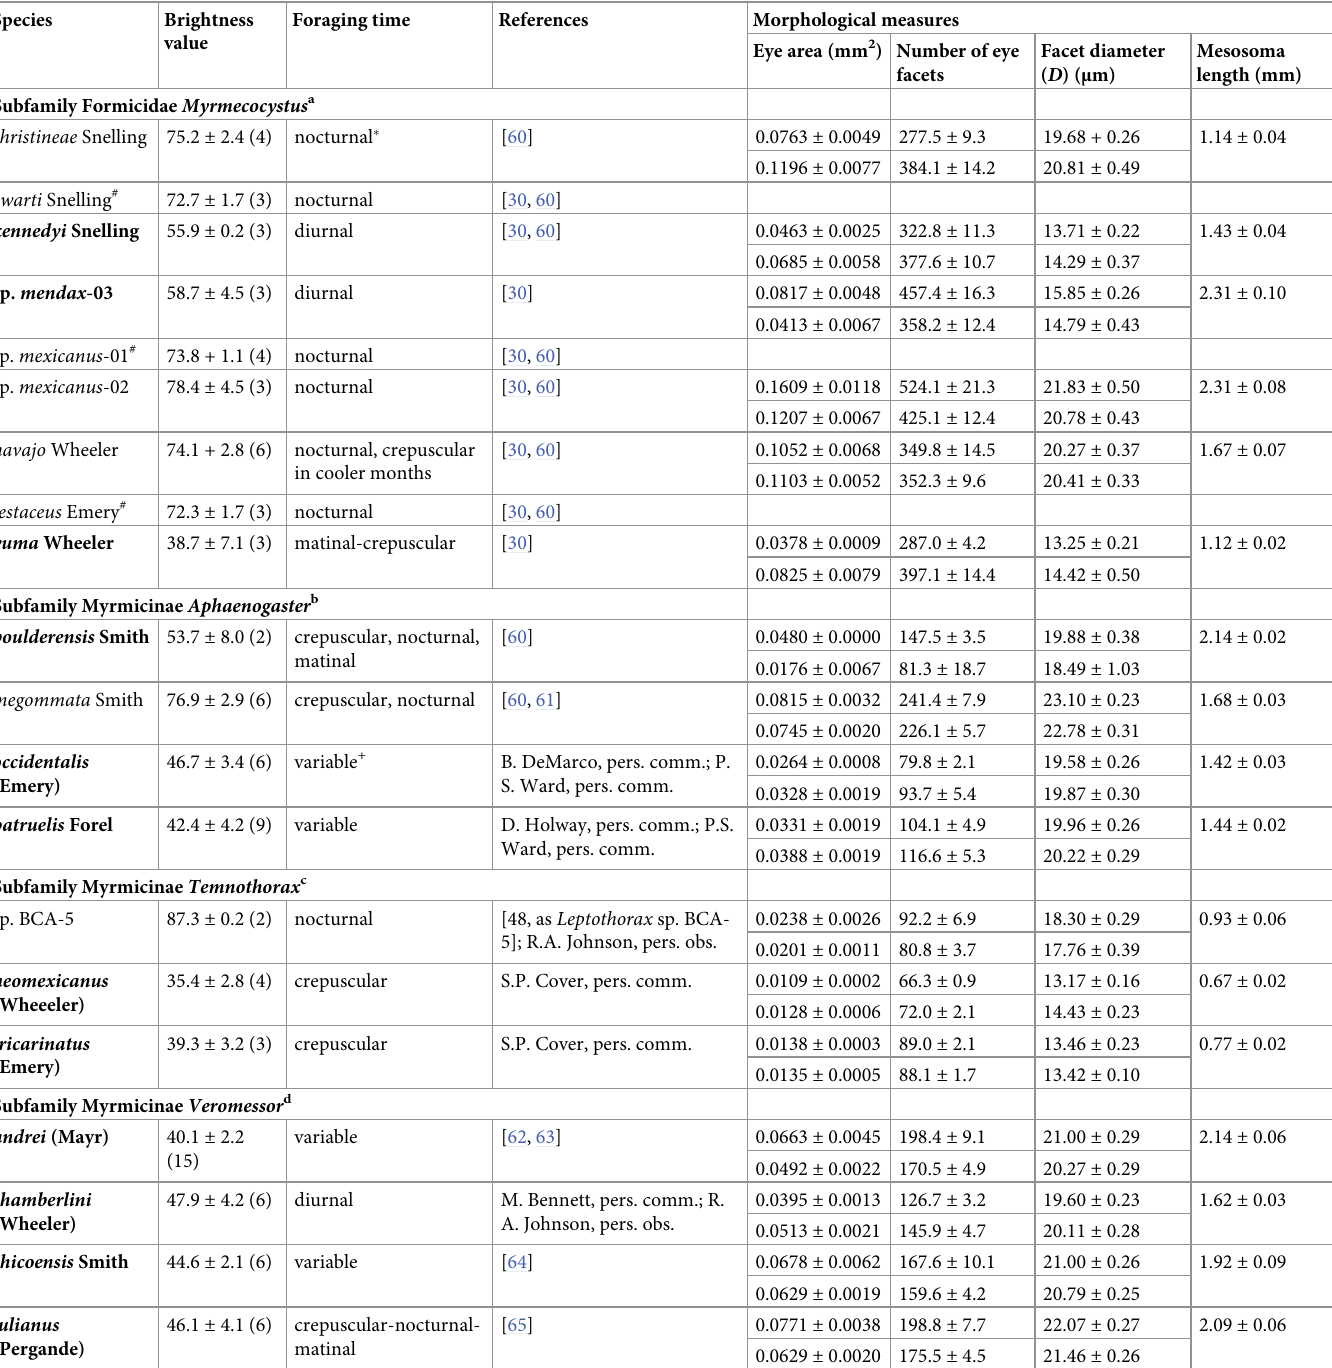
Table 1. Brightness values, foraging time, and the four morphological traits measured for ant species examined in this study. Brightness values are given as mean ± 1 SE (number of workers) (see text). Morphological measures are given as mean ( ± 1 SE) (also see Figs 5 & 7–9); for the three eye traits, values on the first line are raw data, values on second line are estimated marginal mean values using mesosoma length as a covariate in a multivariate analysis-of-covariance. Species are listed alphabetically by subfamily, genus, and species within each genus. Taxonomy follows Bolton [59]; species followed by a number are undescribed or in the process of revision [see 45]. Pale species in normal font; dark species in bold font (see